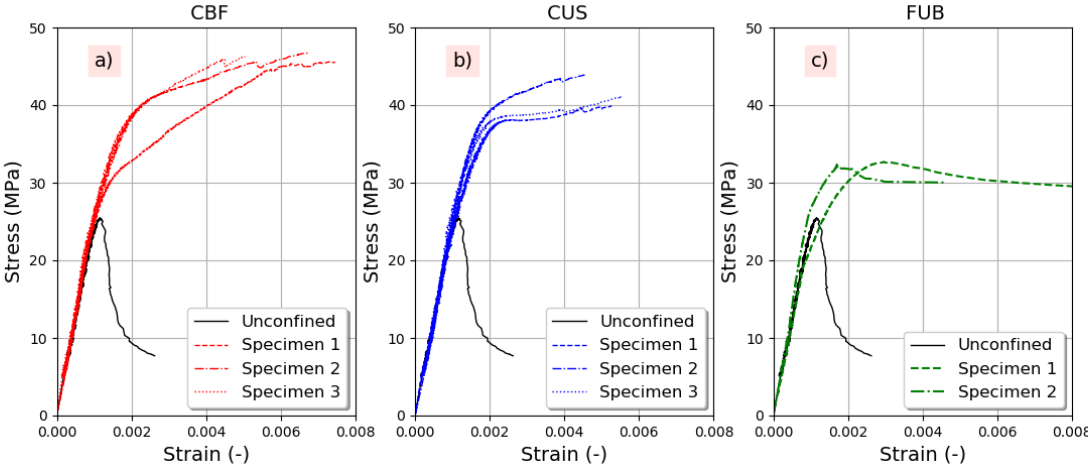
Figure 5. Compressive experimental curves of FRP-reinforced RAC-100R-100R-4.